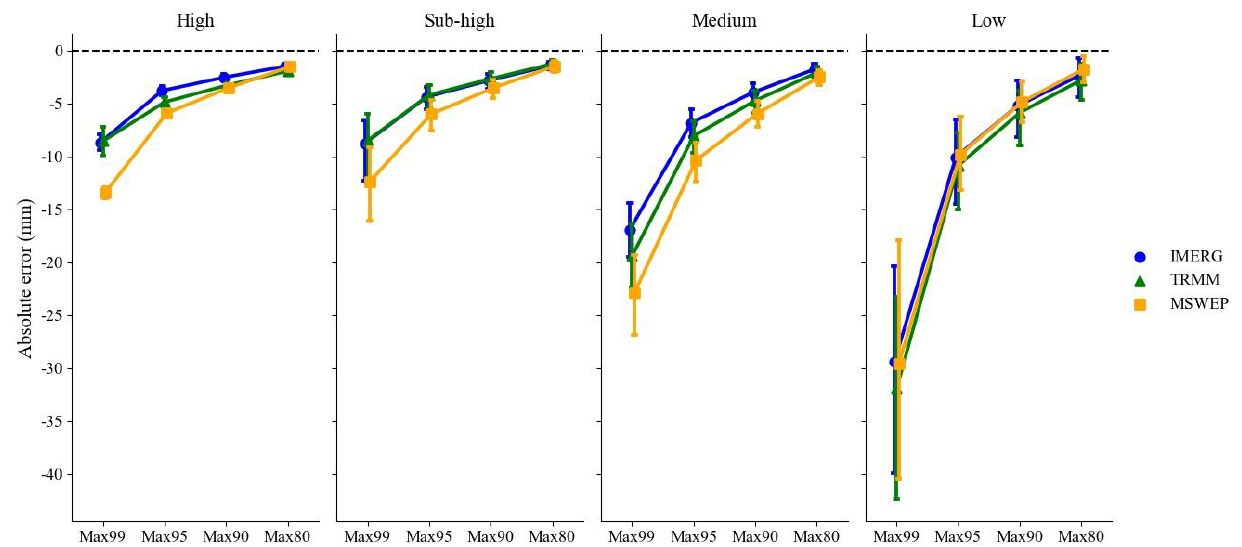
Figure 9. Absolute error between precipitation products and observed data on the altitude gradient in the daily heavy rainfall series.